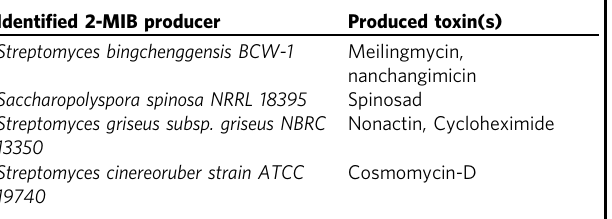
Table 1 Streptomycetes that produce 2-MIB and other compounds that are toxic to